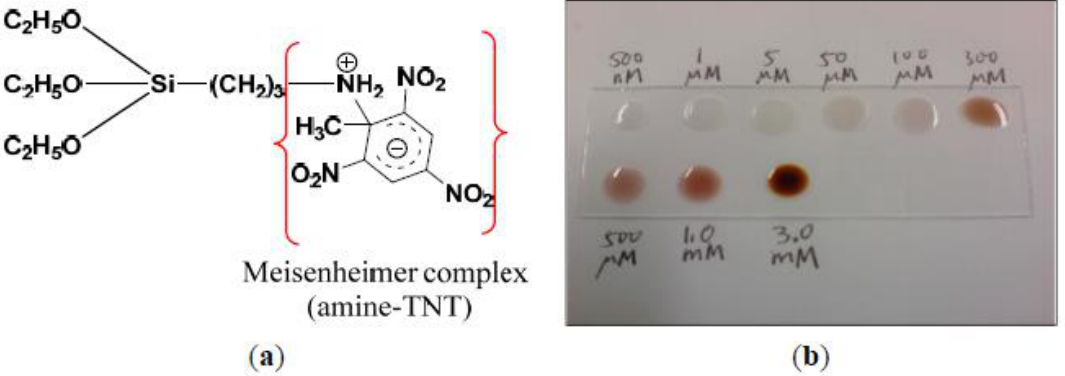
Figure 15. Functionalized Silica Nanoparticles for TNT detection. ( a ) The complex between the amine group and TNT molecule and ( b ) a gradual change in color as the TNT concentration increases [98].